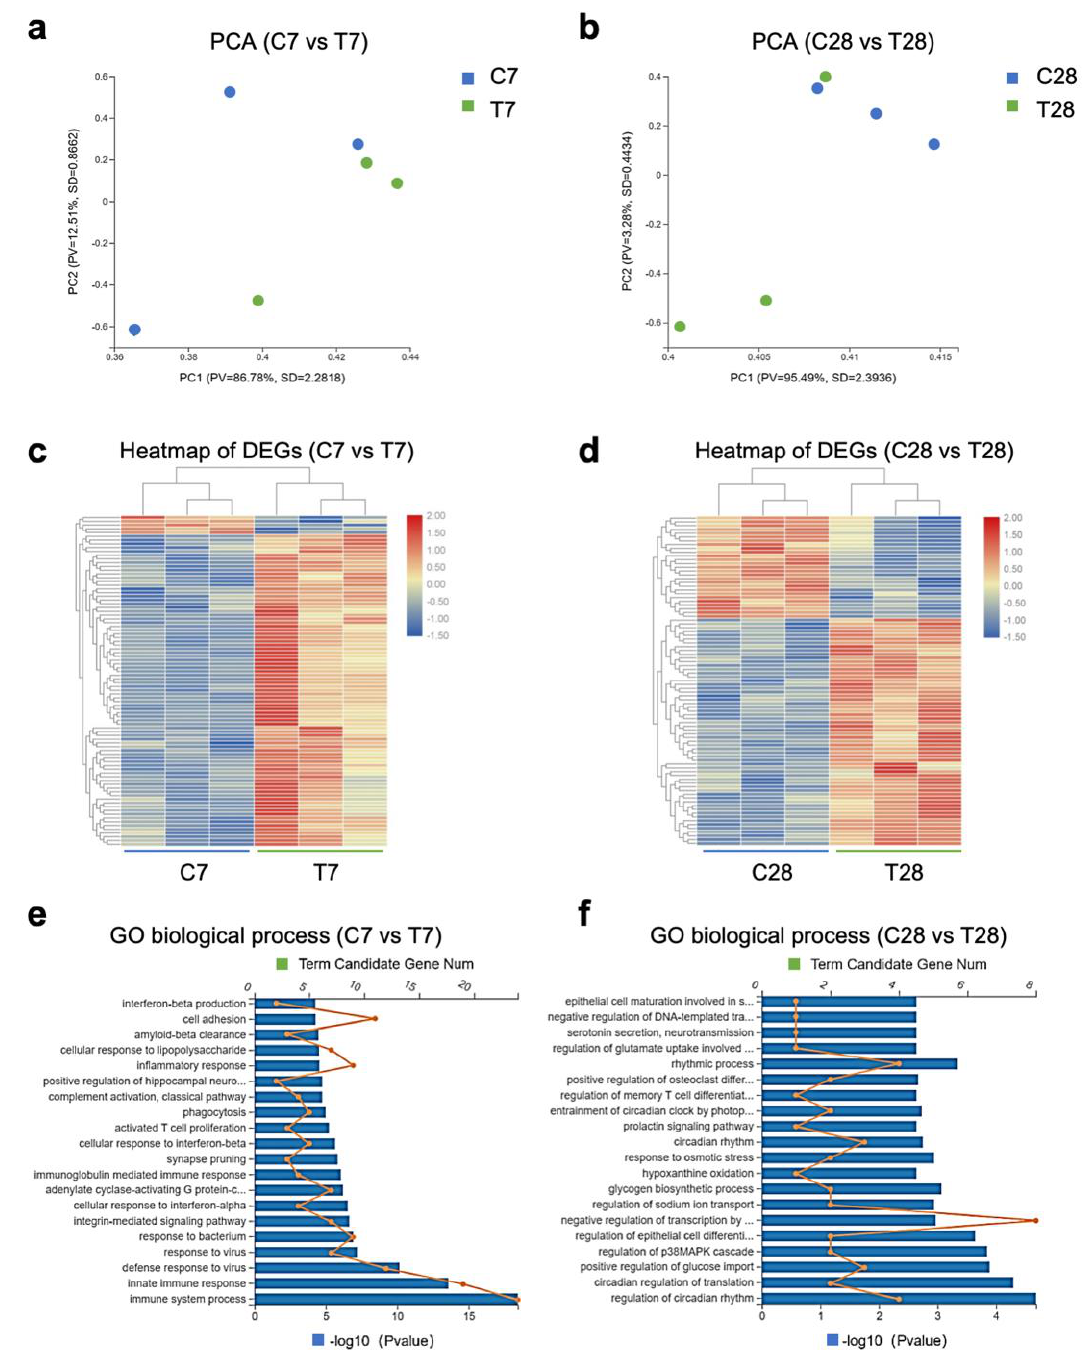
Figure 3. Transcriptome analysis of hippocampus post-TBI. PCA of the hippocampus RNA se- quencing data at 7 days ( a ) and 28 days ( b ) post-TBI ( n = 3 per group). Heatmap of DEGs in the hippocampus at 7 days ( c ) and 28 days ( d ) post-TBI ( n = 3 per group). GO biological process enrich- ment analysis of DEGs in the hippocampus at 7 days ( e ) and 28 days ( f ) post-TBI ( n = 3 per group). TBI, traumatic brain injury; PCA, principal component analysis; DEGs, differential expressed genes; GO, gene